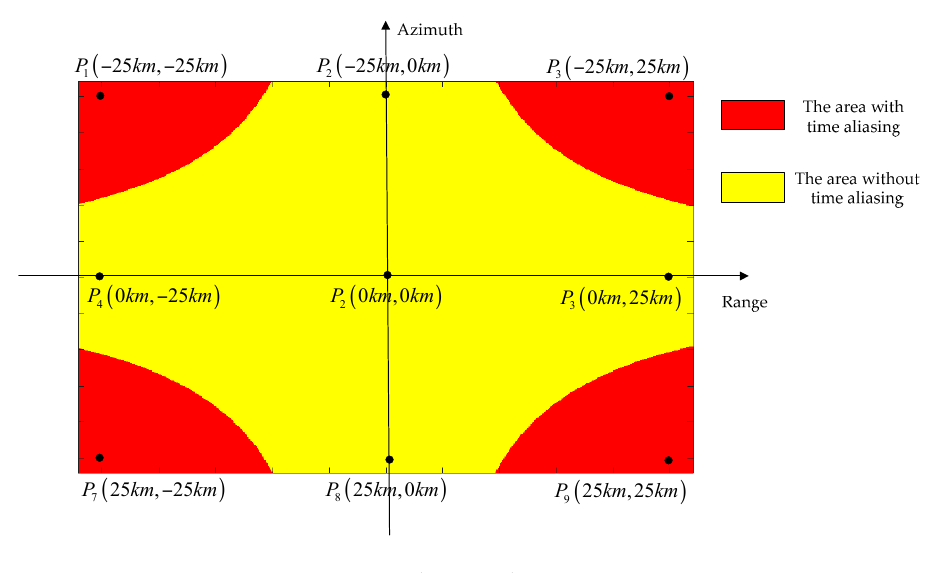
Figure 6. The time aliasing area.